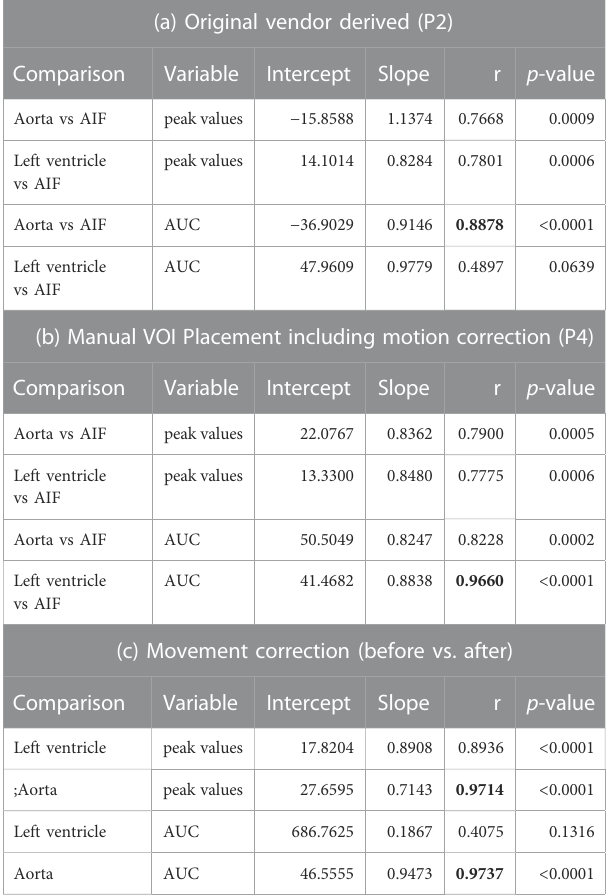
TABLE 1 Overview of correlation and regression parameters between each input function. (A) Shows comparisons using peak values and area under the curveofbothimagederivedinputfunctionstothearterialfunctionbeforeand (B)aftermovementcorrection.(C)Indicatesadirectcomparisonbetweenpeak values and area under the curve before and after movement correction. The best correlation values before and after movement correction are depicted in bold. P3 was not included as the IDIF is the same as in